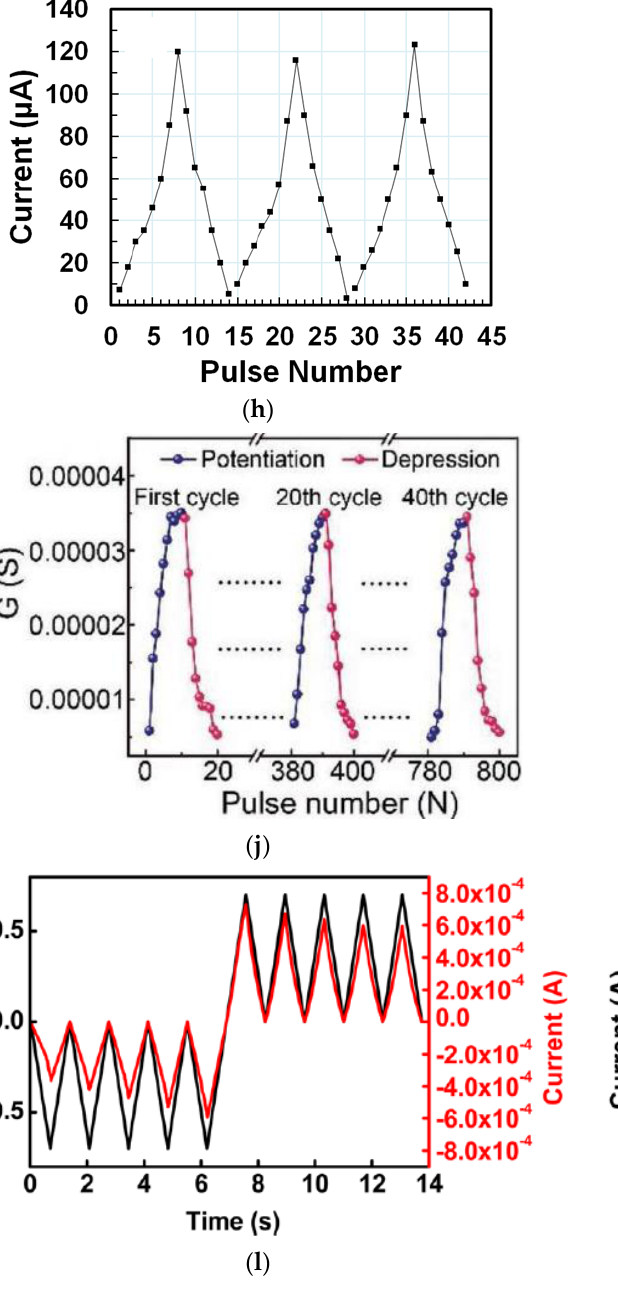
Figure 2. Analog switching characteristics of synaptic memristors based on natural organic mate- rials of ( a ) cellulose nanocrystal [54], ( b ) zein from maize [14], ( c ) trypsin [26], ( d ) lignin [24], and ( e ) honey [17]. Current-time responses with applied voltage pulses of opposite polarity for memristors based on ( f ) cellulose nanocrystal [54], ( g , h ) honey [17], ( i – k ) bombyx mori silk [55], and ( l , m ) lignin [24]. In ( k , m ), # is the number of pulses. In ( m ), black dots are for potentiation and red dots for depression.